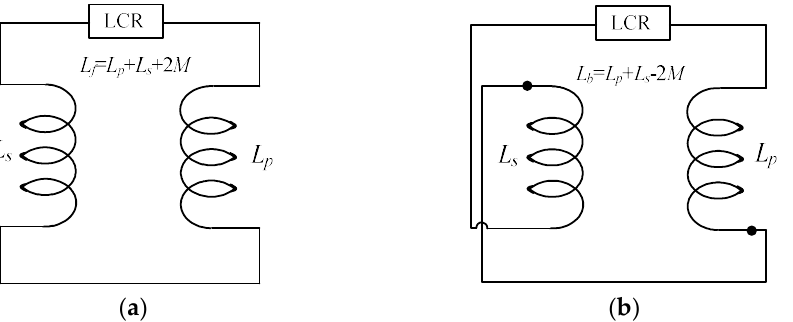
Figure 4. Two different connection mode for measuring mutual inductance. ( a ) Forward mode. ( b ) Backward mode.